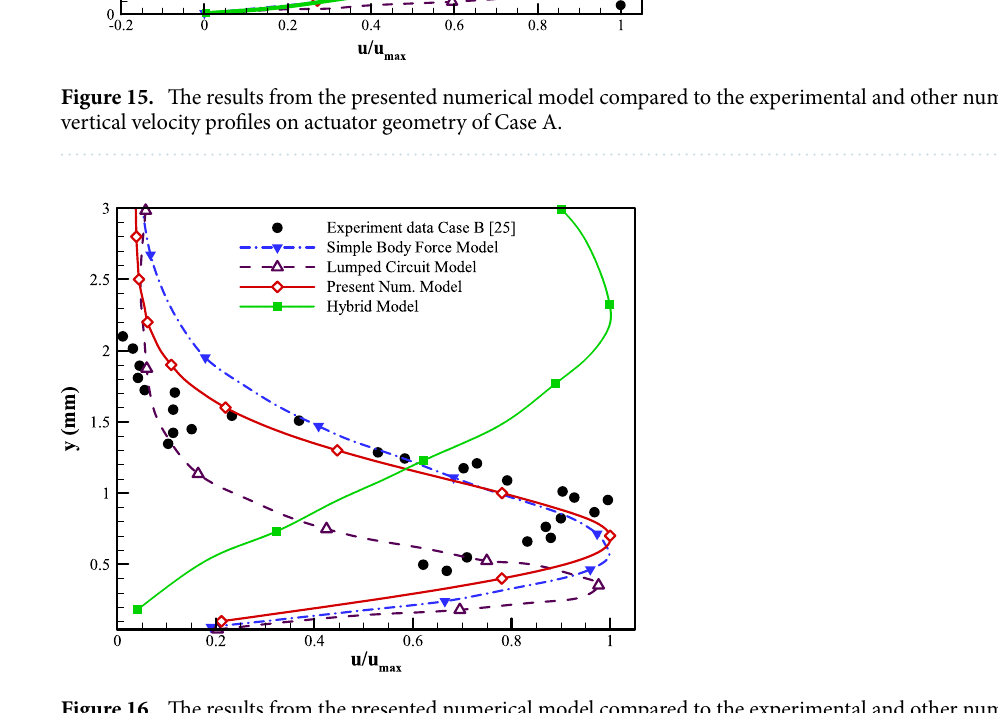
Figure 16. The results from the presented numerical model compared to the experimental and other numerical vertical velocity profiles on actuator geometry of Case